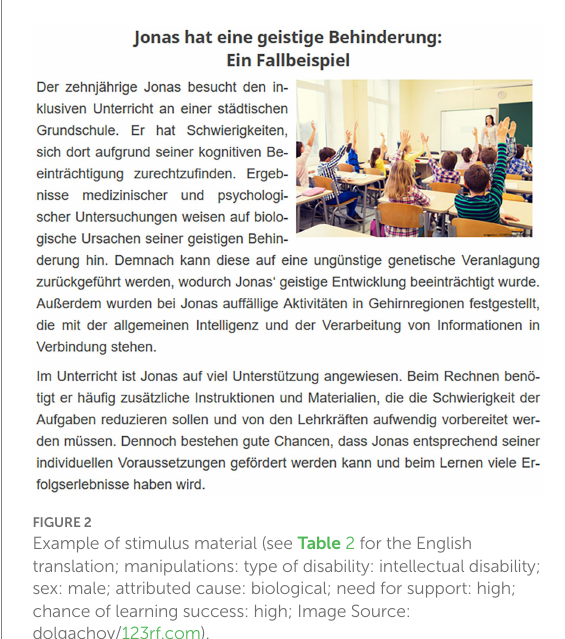
FIGURE 2 Example of stimulus material (see Table 2 for the English translation; manipulations: type of disability: intellectual disability; sex: male; attributed cause: biological; need for support: high; chance of learning success: high; Image Source: dolgachov/123rf.com).